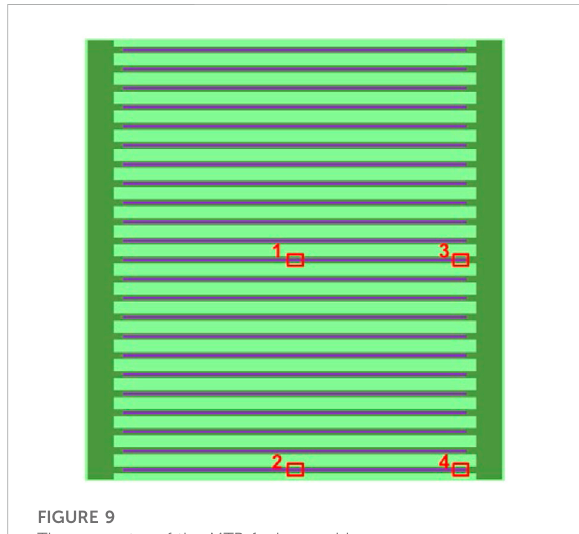
FIGURE 9 The geometry of the MTR fuel assembly.